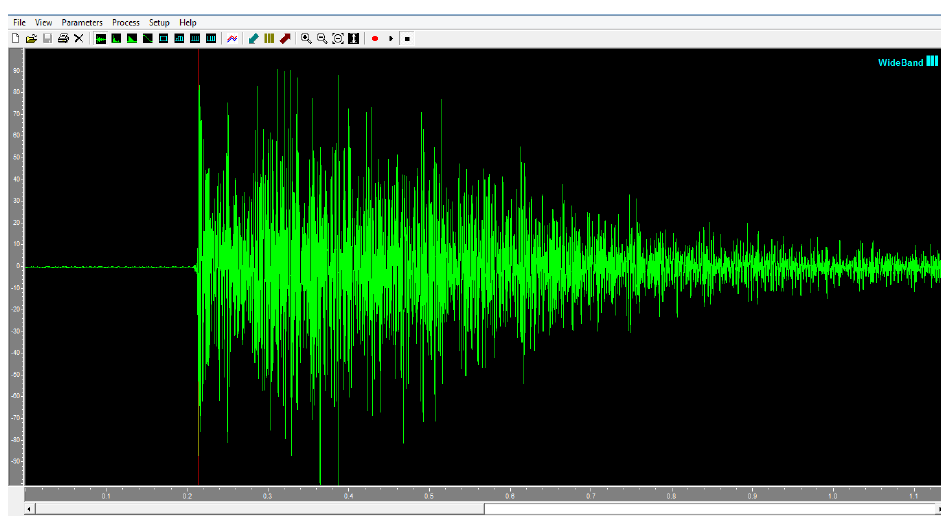
Figure 16. Measured results of reverberation time (T 20 ).